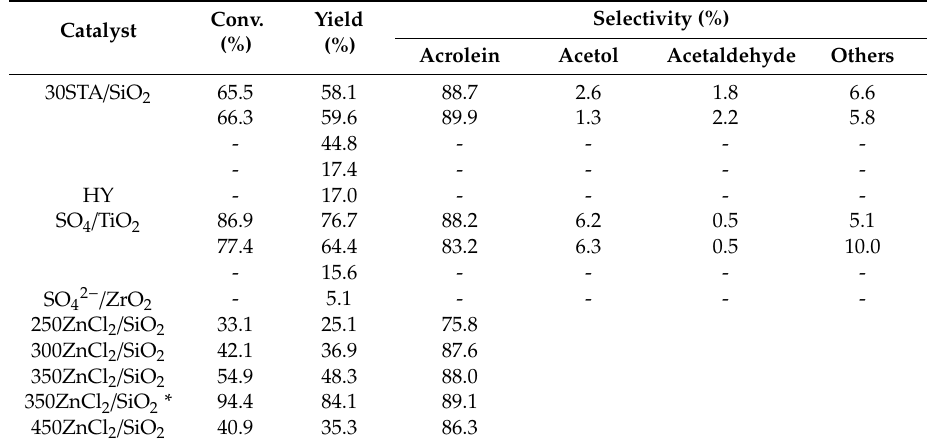
Table 3. The results of glycerol dehydration over acid catalysts at 210 ◦ C.